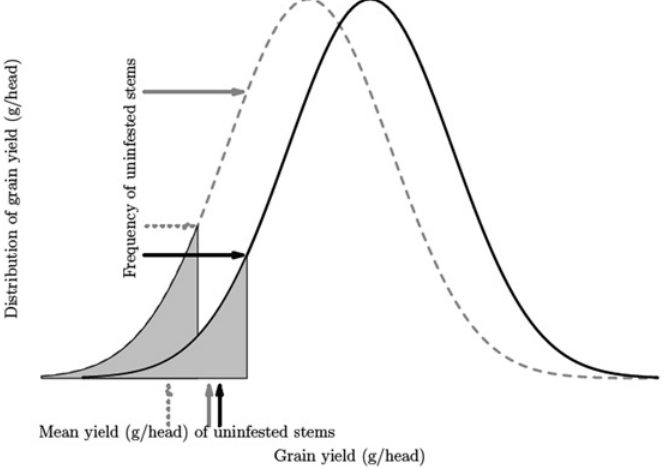
Fig 2. Hypothesized Cephus cinctus oviposition choice mechanisms. Standardized grain yield of wheat heads is represented by a N(0, 1) distribution (solid black curve). Dashed gray curve represents wheat which is 25% lower yielding due to either intra- or inter-specific competition and shaded areas represent stems that were not infested by C. cinctus . Solid black arrows correspond to observed frequency and mean weight of grain in the uninfested category. Solid gray arrows represent observed value under the same choice mechanism but lower overall yield. Dashed gray arrows represent a modification of the C. cinctus choice threshold where wheat stems which could have been considered inappropriate under higher overall potential yields are now selected for oviposition.